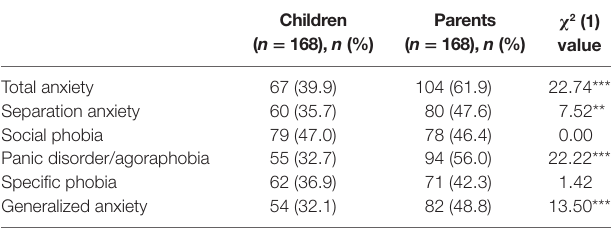
Table 2 | Counts, Percentages, and χ 2 (1) Values of Children with at Least Subclinical Anxiety Symptoms According to Parent and Child Assessment. children ( n = 168), n